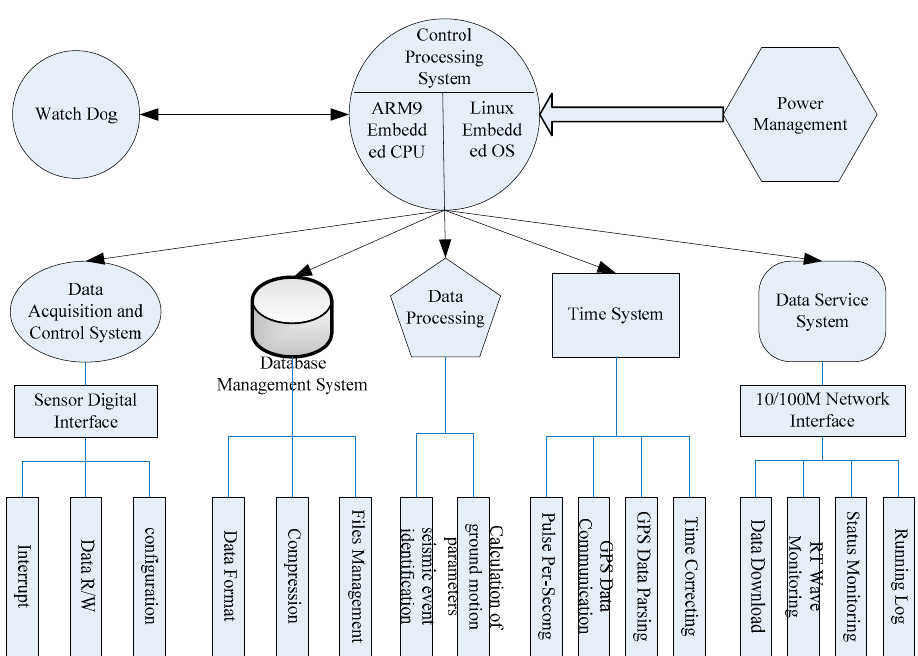
Figure 4. Functional structure of the seismic intensity rapid reporting instrument.